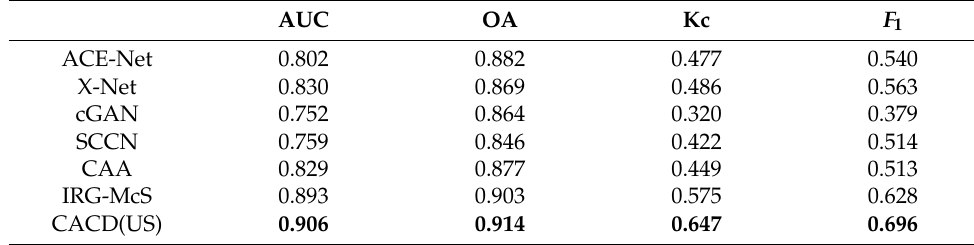
Table 4. Quantitative evaluation on the Toulouse dataset.